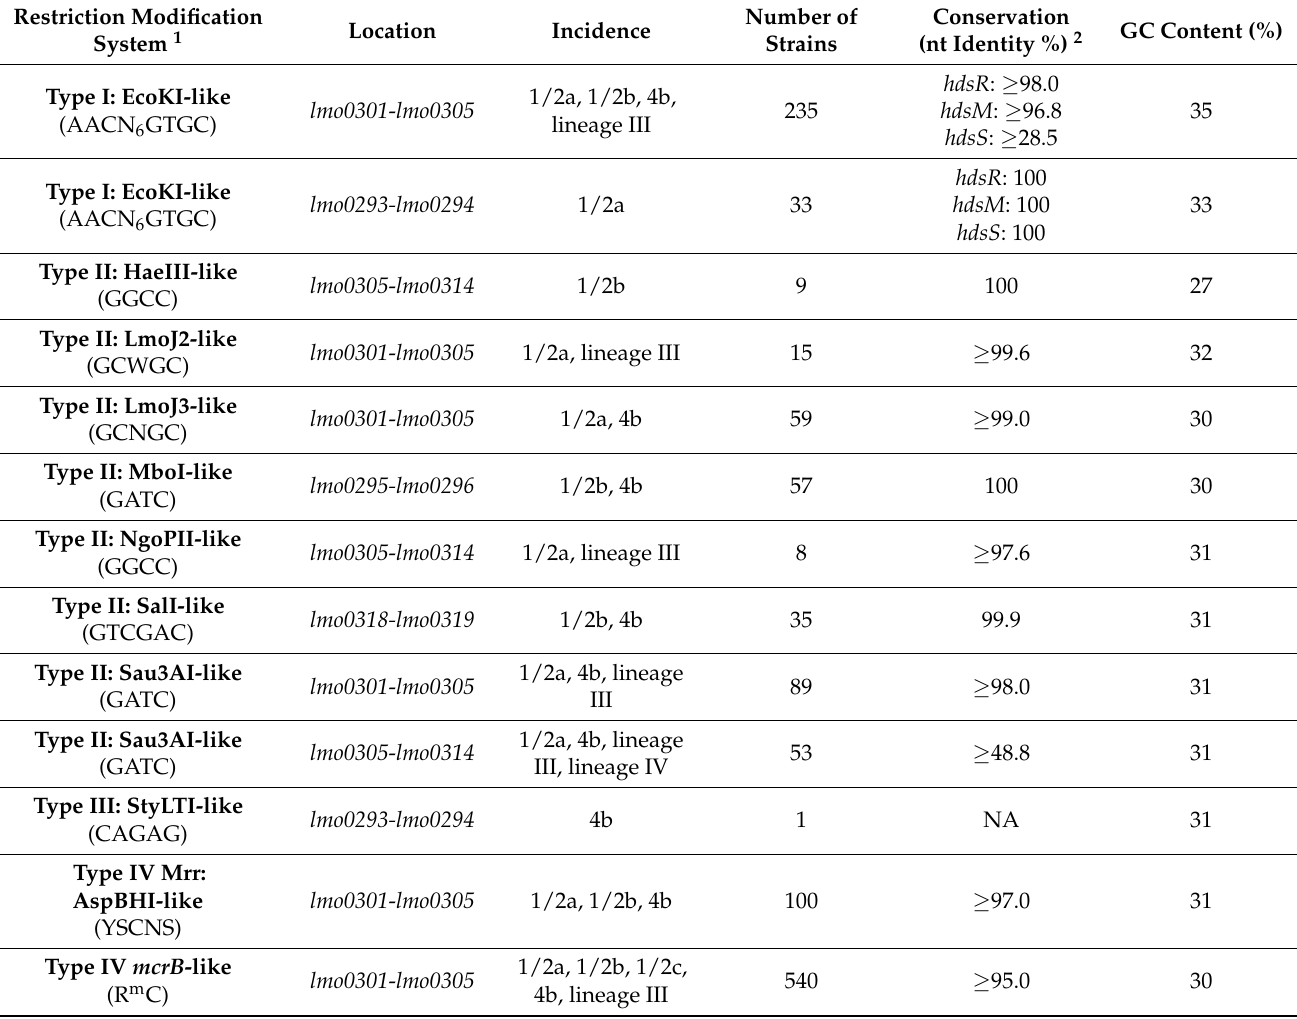
Table 1. Distribution and conservation of restriction modification systems harbored in and adjacent to the ICR in the analyzed Listeria genomes. Canonical recognition sites are in